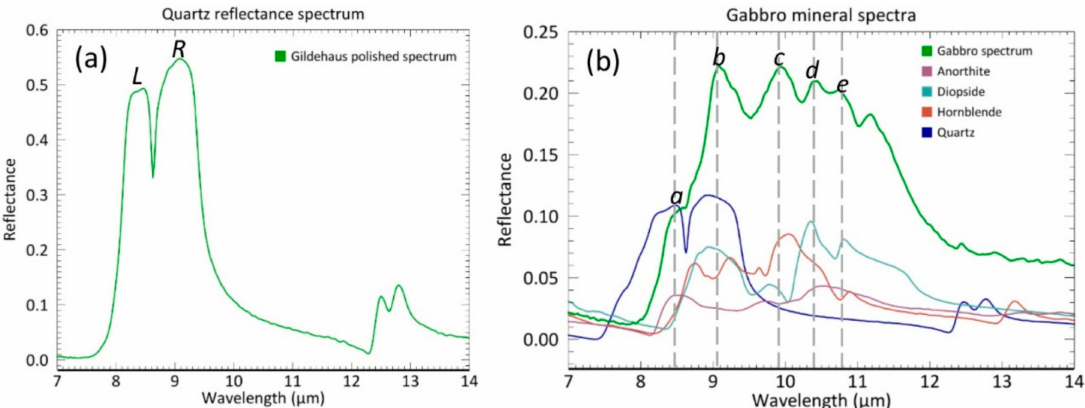
Figure 3. ( a ) An example of a quartz reflectance spectrum with the Gildehaus polished spectrum. ( b ) Gabbro polished reflectance spectra, including the spectra of the minerals that contribute to the shape of the Gabbro spectral signature. Mineral spectra are from Johns Hopkins University (JHU) and can be found in the ASTER spectral library in ENVI